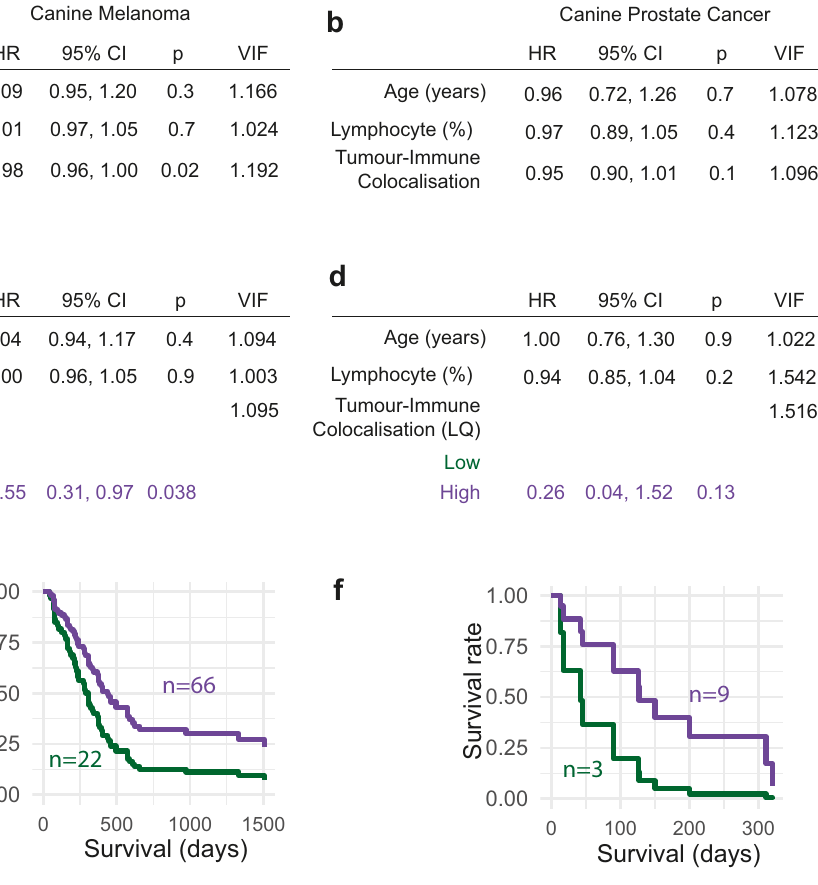
Fig. 5 | Prognostic value of spatial immune in fi ltration. a , b Multivariate Cox regression analyses testing the prognostic value of the colocalisation between cancer cells and lymphocytes as a continuous variable for overall survival in mel- anoma, n =88 ( a ) and prostate canine cancers, n =12 ( b ). Other variables included areageandAI-basedlymphocytepercentage(seeMethods).Thesamemultivariate model but incorporating the colocalisation between cancer cells and lymphocytes as a dichotomised variable using the upper three quartiles as high group, lower quartile as low group, determined individually for melanoma ( c ), and prostate ( d )